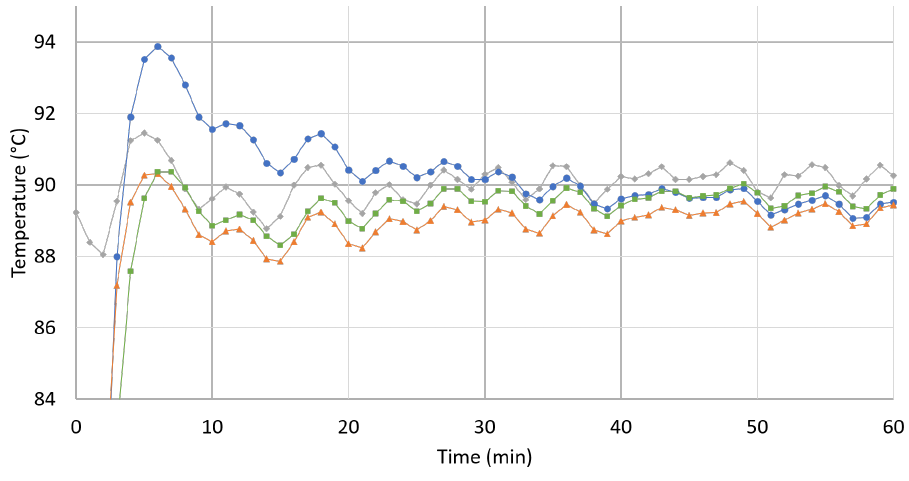
Figure 4. Polymerization temperature for small-sized system for different GTR/(GTR + styrene)